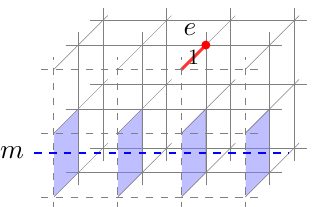
Figure 26. The only nontrivial topological defects on the rough boundary are the m -strings. The e -particles are